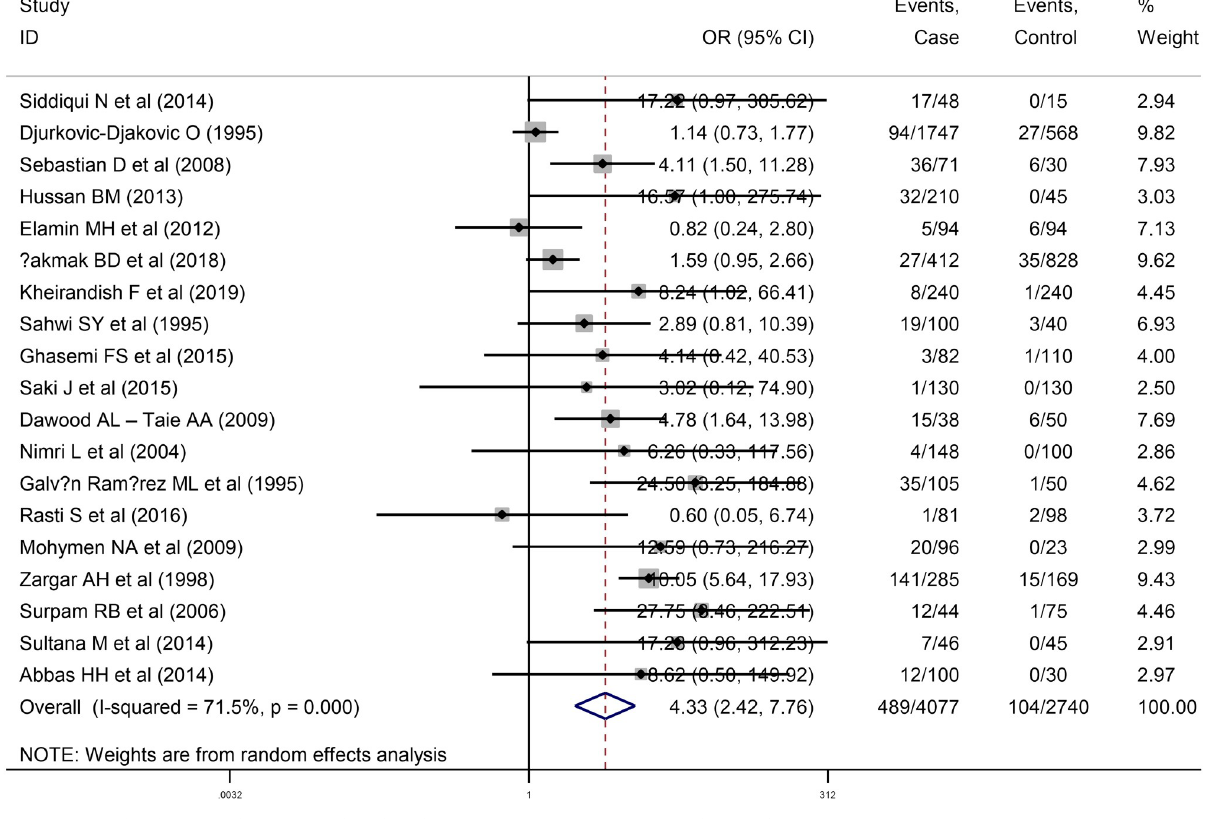
Fig 7. Forest plot diagram of case-control studies showing IgM seropositivity rates of T . gondii .